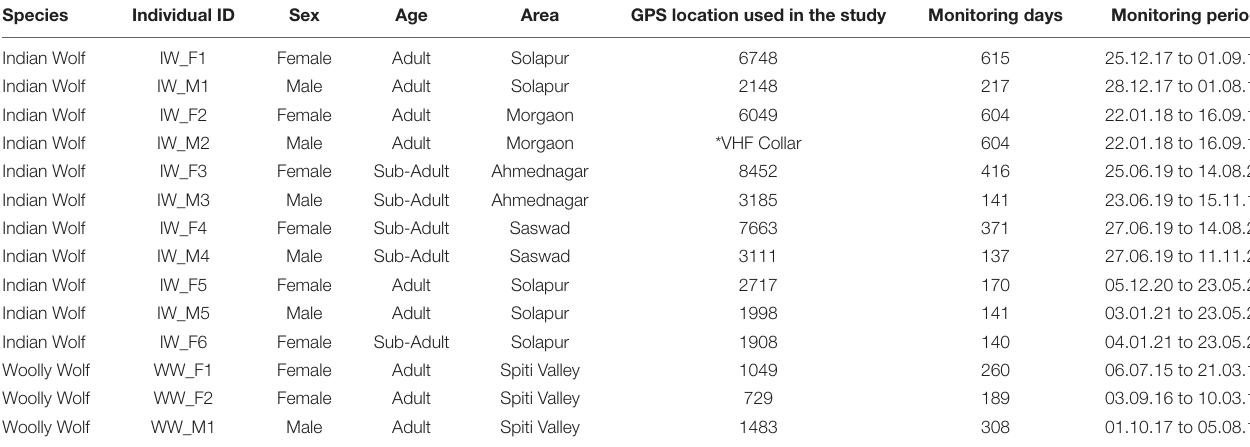
TABLE 1 | Detail of each individual’s characteristics and number of locations used to study the movement, space use and habitat use of wolf in India. Species Individual ID Sex Age Area GPS location used in the study